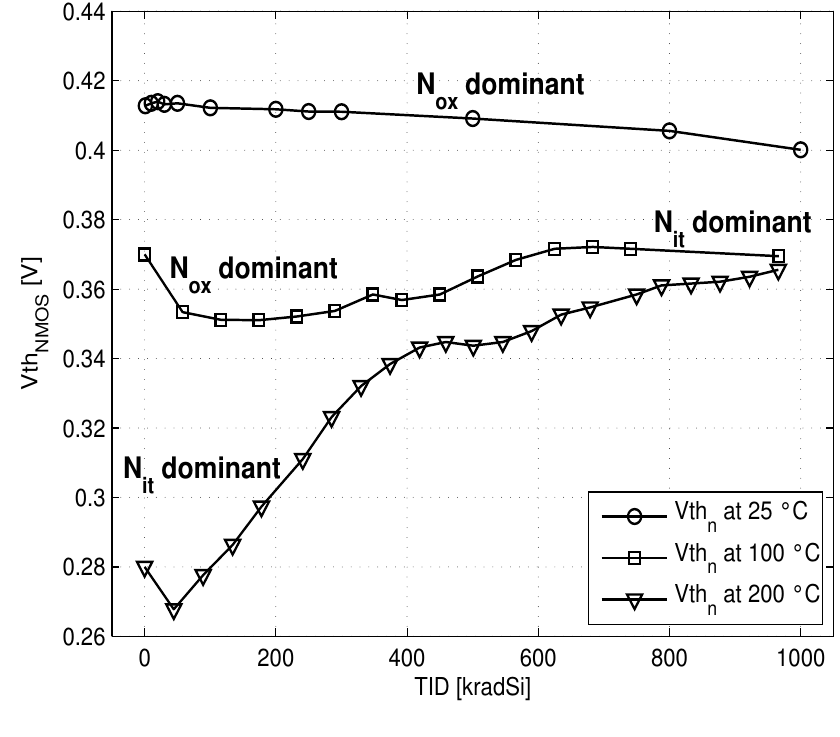
Figure 13. Measured NMOS voltage threshold vs TID at different